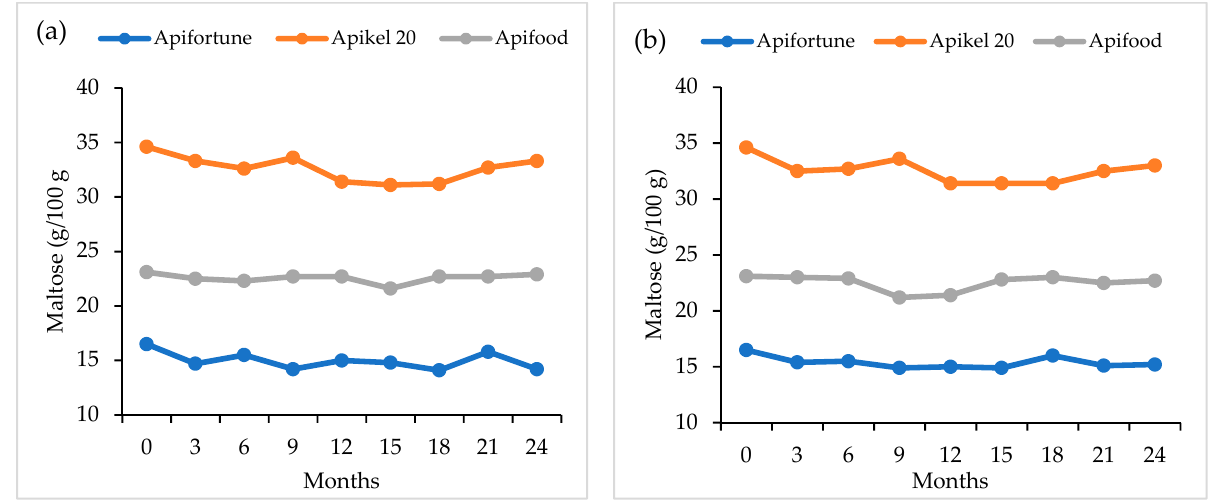
Figure 12. Changes of maltose content in syrups during storage at 10–14 °C ( a ) from 2012 and ( b ) from 2013.